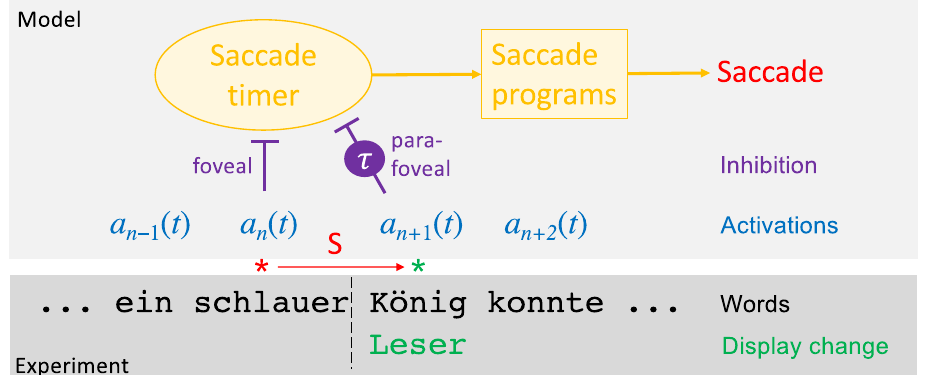
Figure 2. Modeling eye-movement control in the boundary paradigm. Experiment: the saccade S triggers the display change from the preview König to the fixated word Leser . Model: Word-based activations indicate states of lexical processing for each word. The saccade timer initiates a cascade of processes that produce the saccade. Inhibition of the saccade timer can delay the saccade, which is observed as increased fixation duration. Based on model simulations, we investigated whether inhibition by foveal (word n ) alone or with